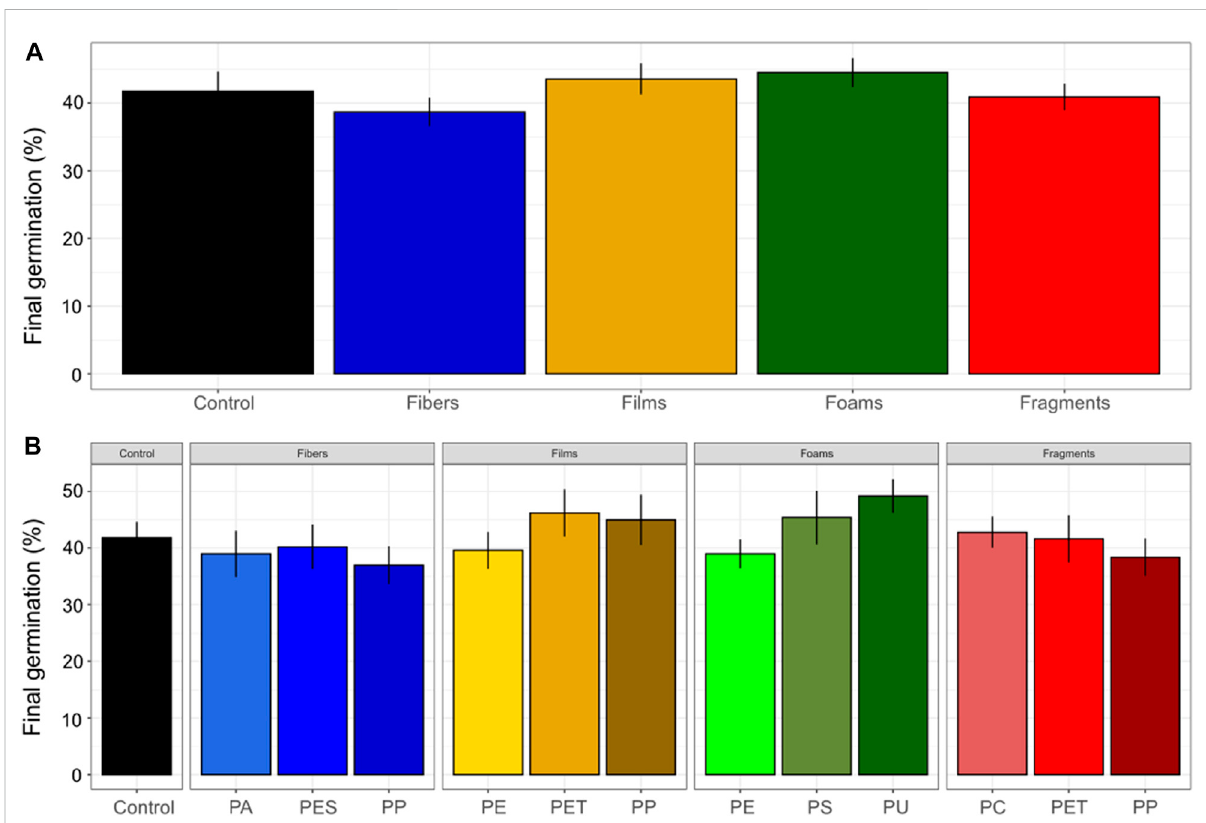
FIGURE 3 Final germination percentage of seeds of Daucus carota. Microplastic shape (A) and polymer types effects (B) on fi nal germination was evaluated. Differences between microplastic types and the control without microplastics) were tested using Dunnett test. Differences between polymer types within each microplastic shape were tested using Tukey test (** p < 0.05; * p < 0.1). Polymers: PA (polyamide), PES (polyester), PP (polypropylene), LDPE (low density polyethylene), PET (polyethylene terephthalate), PS (polystyrene), PU (polyurethane), and PC (polycarbonate). n = 10 for microplastics, n = 18 for control samples. The fi nal germination percentage indicates the potential to complete germination (where the minimum is 0% and the maximum is